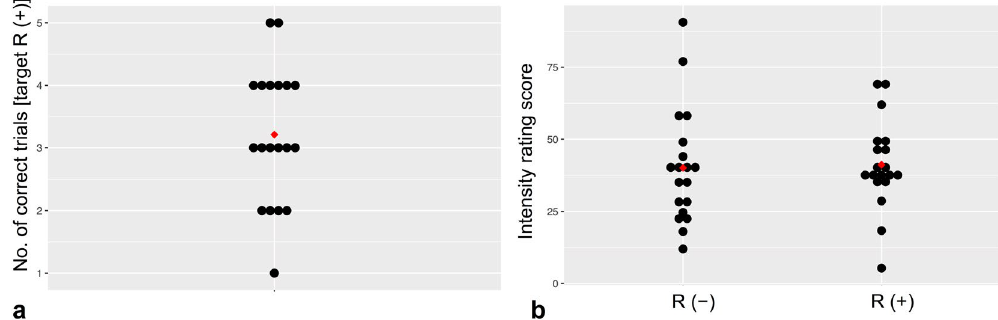
Figure 1. Results from behavioural test. ( a ) 3-AFC discrimination test. The black dots show each participant with their number of correct trials out of 9; the red dot represents the mean of correct trials. ( b ) Intensity ratings for ( + )-rose oxide and ( − )-rose oxide. The black dots show the intensity rating of each participant. The red dot indicates the mean of the intensity ratings of ( + )-rose oxide and ( − )-rose